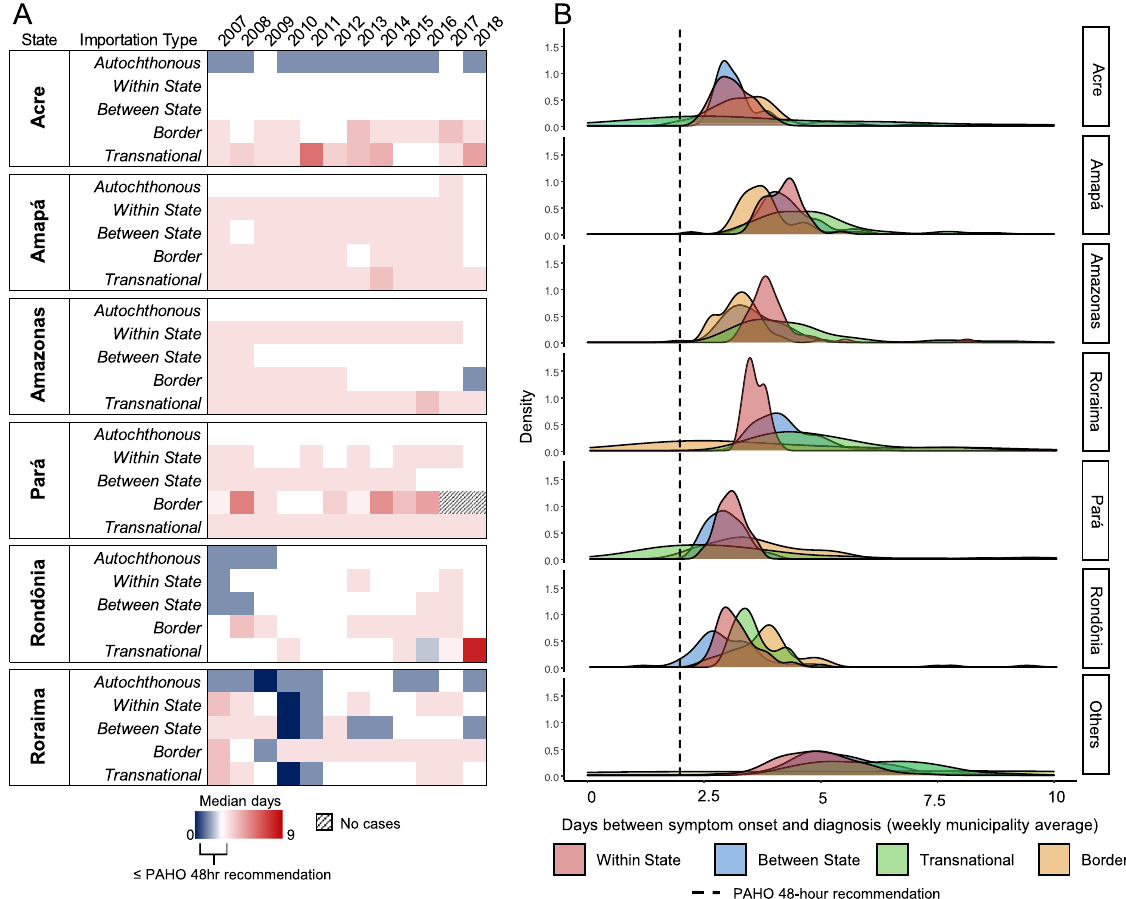
Figure 5. Analysis of time between symptom onset and diagnosis to assess Brazil’s health system response capabilities. ( A ) Heatmap demonstrating the median number of days that passed between symptom onset and malaria diagnosis compared to the PAHO 48 h recommendation. States are broken down into the different types of malaria cases denoted from the proposed conceptual framework. ( B ) Density plots of the distribution of days between symptom onset and diagnosis based on weekly municipality averages and split by case type. The dotted line represents PAHO’s 48 h